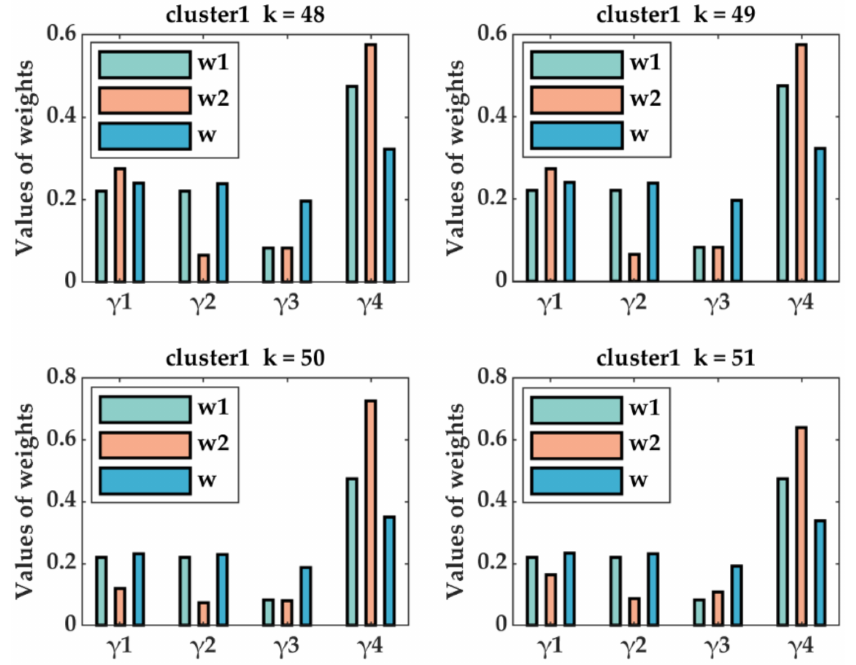
Figure 5. Weights of each index for DGs in cluster